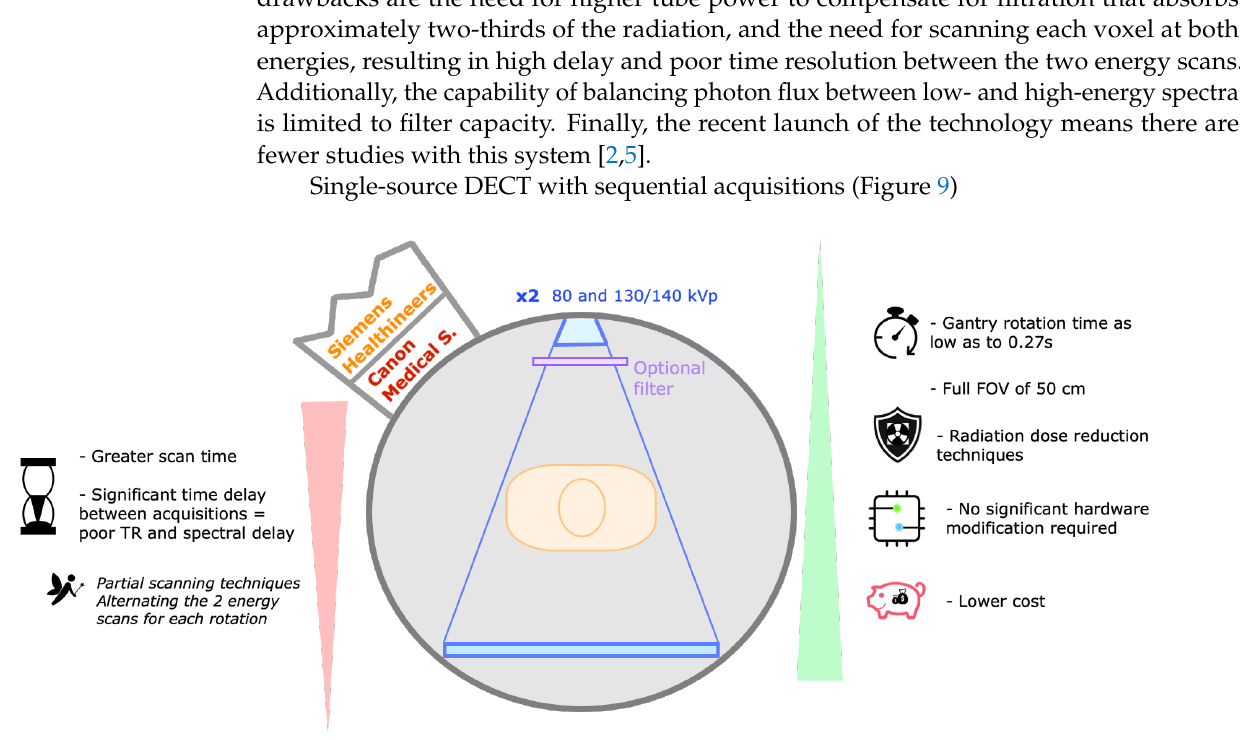
Figure 9. Single-source DECT with sequential acquisitions. Schematic representation of single-source DECT with sequential acquisitions and its drawbacks (listed on the left) and strengths (listed on the right). These scanners (commercialized by Siemens Healthineers and Canon Medical Systems) are composed of a single source and detector (optional filter). The low-energy scan typically uses 80 kVp, whereas the high-energy scan may use 130 or 140 kVp. The significant time delay between acquisitions leads to poor time resolution (TR) and spectral delay. FOV—field of view, kVp—peak kilovoltage, s—second.